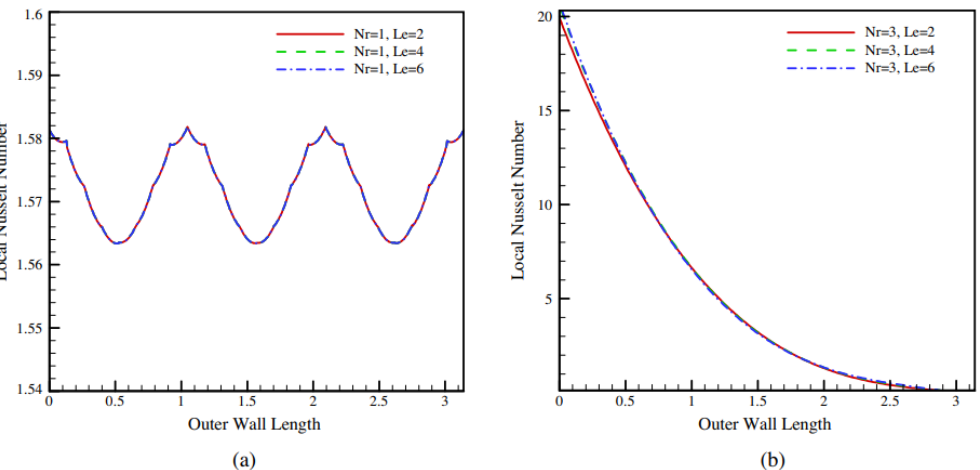
Figure 5. Local Nusselt numbers vs. Le numbers when ( a ) Nr = 1 and ( b ) Nr = 3. Reprinted with permission from Ref. [19]. 2016, Elsevier.